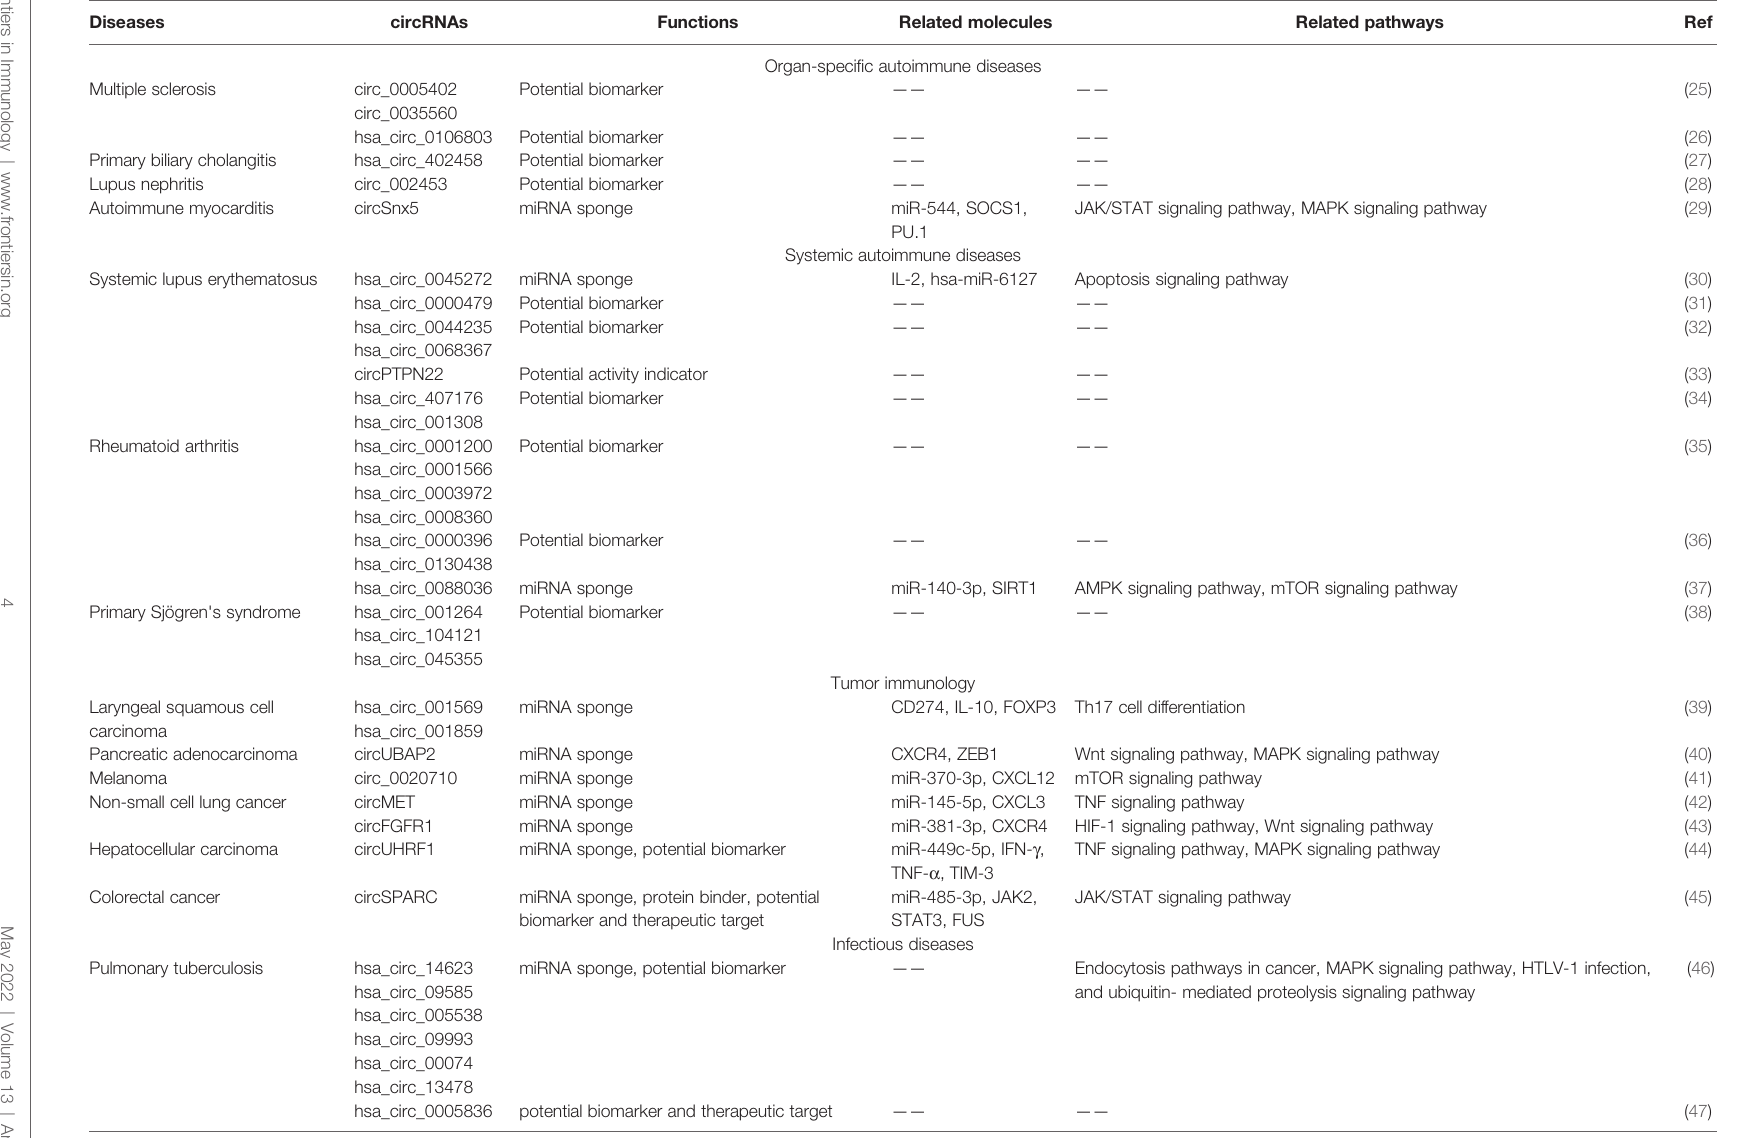
TABLE 1 | Roles of circRNAs in four main immune-related